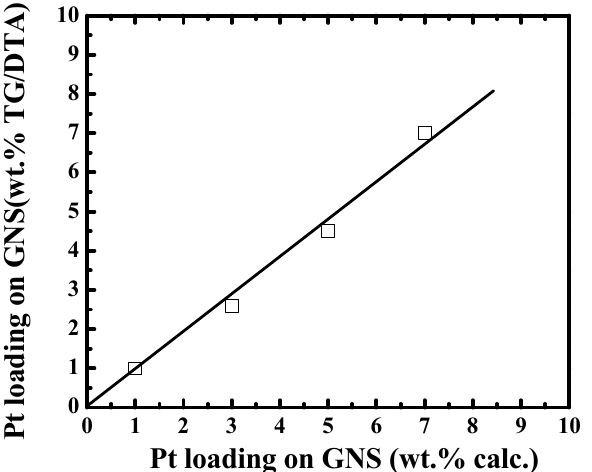
Figure 2. Pt amount on GNS (wt.%) measured by TG/DTA versus calculated Pt amount on GNS ( □ ).